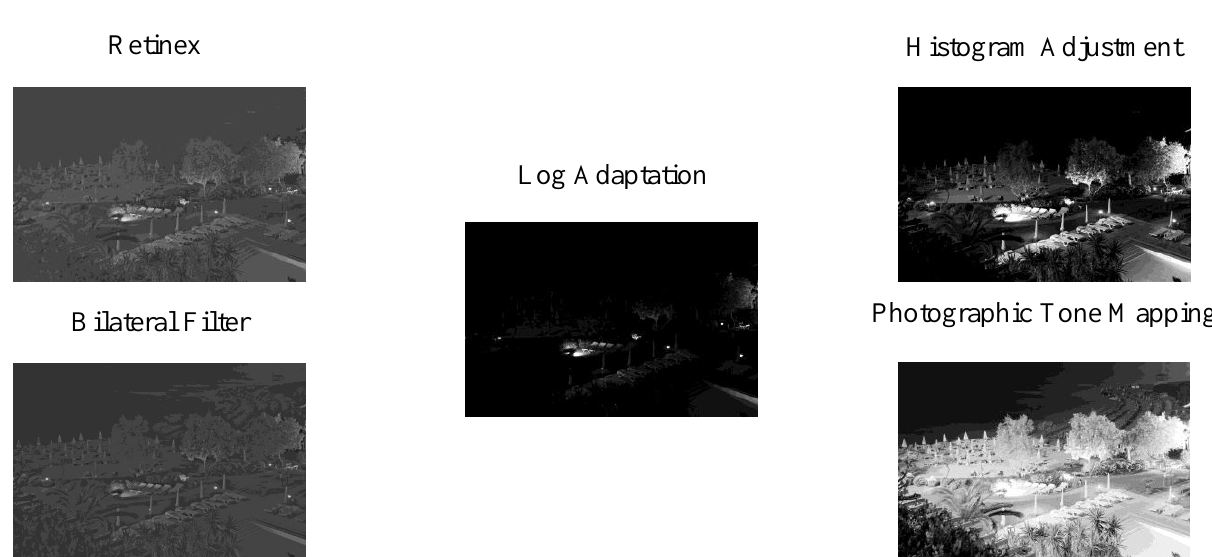
Figure 7. Example images generated using the different tone mapping